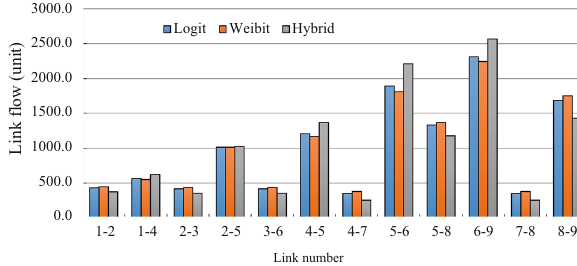
Fig. 3 Total link flows assigned by the logit, weibit and hybrid models